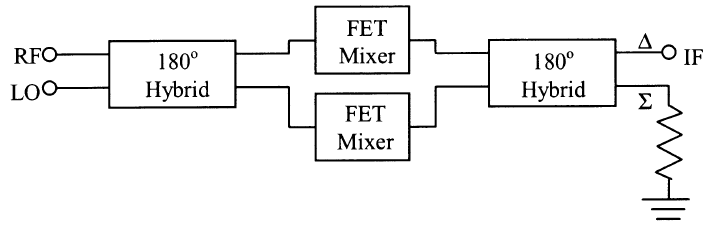
FIGURE 5 Single balanced FET mixer.